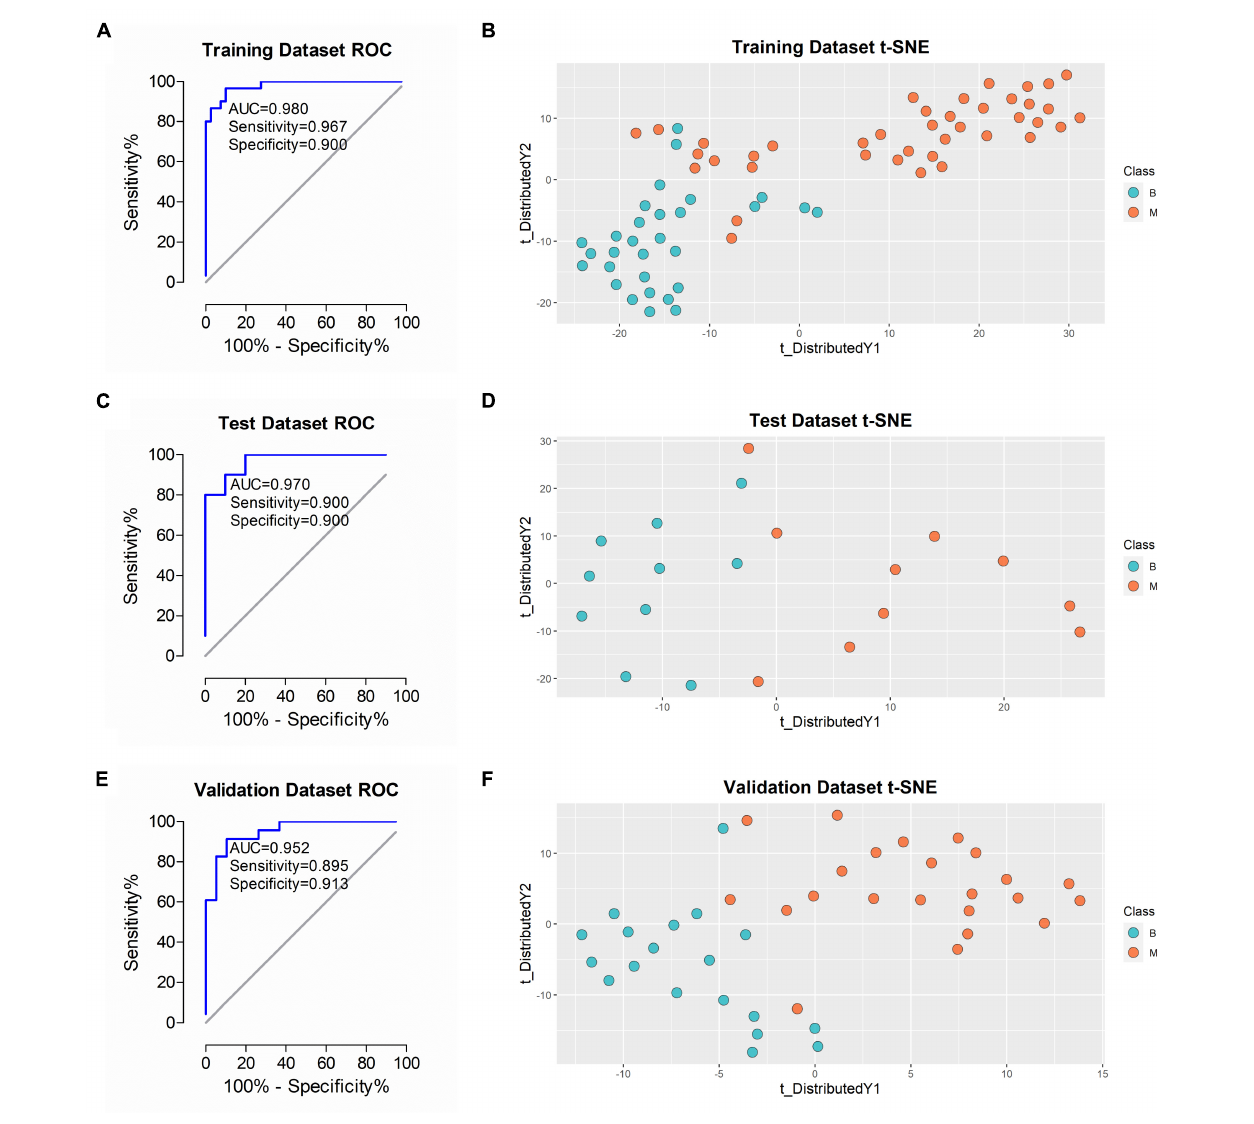
FIGURE 5 | Performance of the classifier in diagnosing malignant from benign in different datasets. (A,C,E) ROC analysis of the classifier in training, test and validation datasets. (B,D,F) t-SNE analysis of the classifier in training, test and validation datasets. *B, benign group; M, malignant